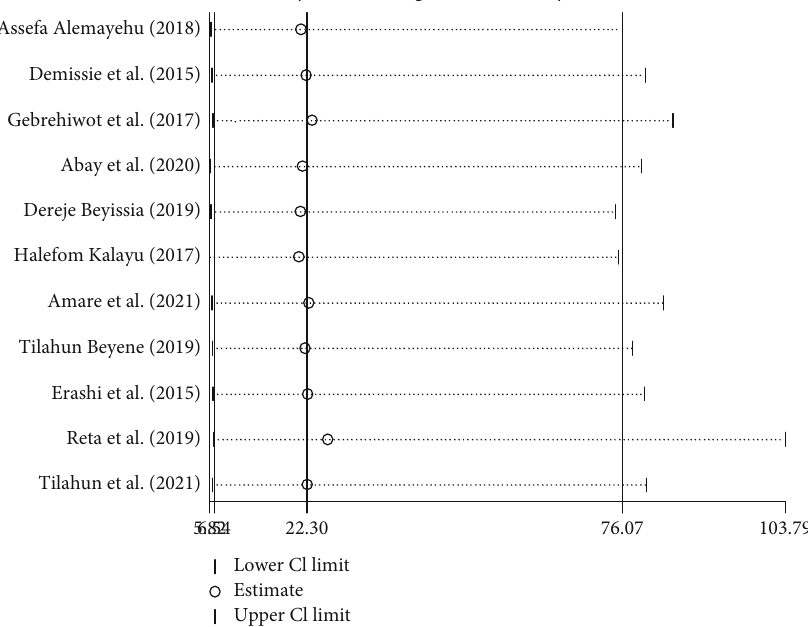
Figure 5: Sensitivity analysis of the prevalence of dual contraceptive use in